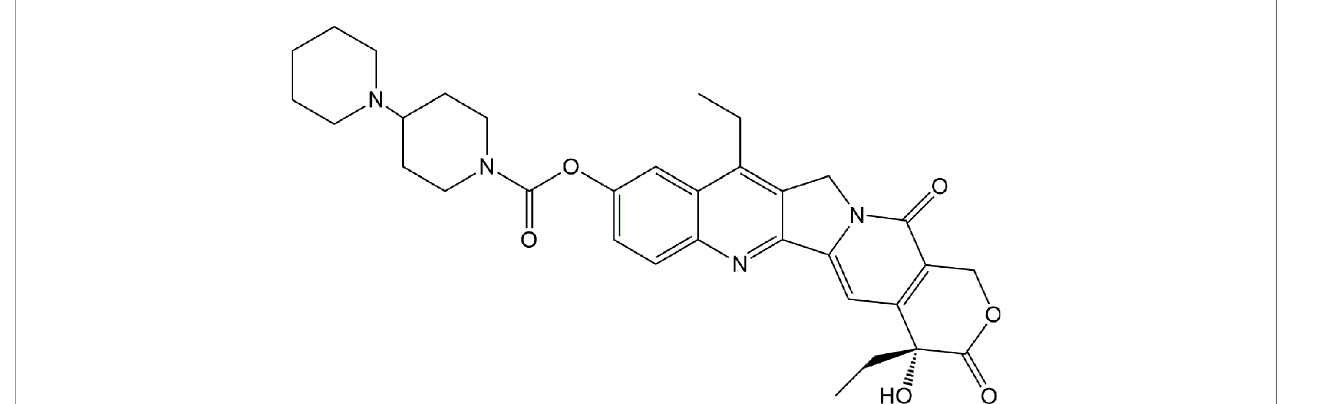
FIGURE 1 | The structure